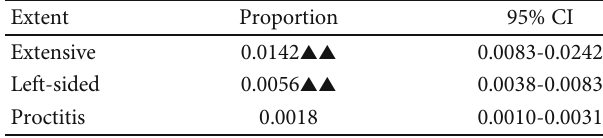
Table 3: Disease extent risk of CRC in UC patients.